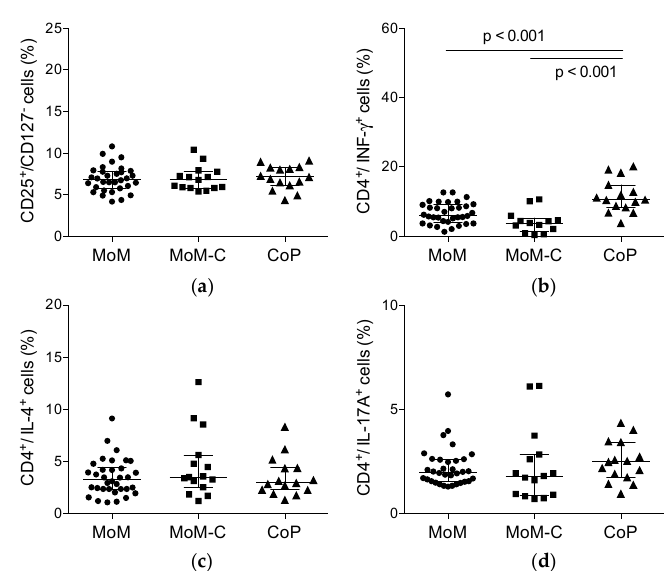
Figure 3. Scatter plots summarizing the results of phenotypic analysis of lymphocyte subpopulations as measured by flow cytometry. The figure presents the percentages as frequencies of CD3 + cells of: ( a ) CD25 + / CD127 − regulatory T cells as frequencies of mononuclear cells; ( b ) CD4 + / IFN- γ + Type 1 (Th1) T helper cells; ( c ) CD4 + / IL-4 + Type 2 (Th2) T helper cells; and ( d ) CD4 + / IL-17A + Th17 T helper cells. Lines with p values connect groups with significant differences. Vertical scatterplot lines show medians with interquartile ranges. MoM, metal-on-metal study group; MoM-C, metal-on-metal control group; CoP, ceramic-on-polyethylene control group. Table 5. Comparison of leucocyte cell counts and metal ion levels between patients without ALTR and patients with ALTR (the values are given in percentages, as frequency of parents). Leucocytes/Blood Metal ion Levels